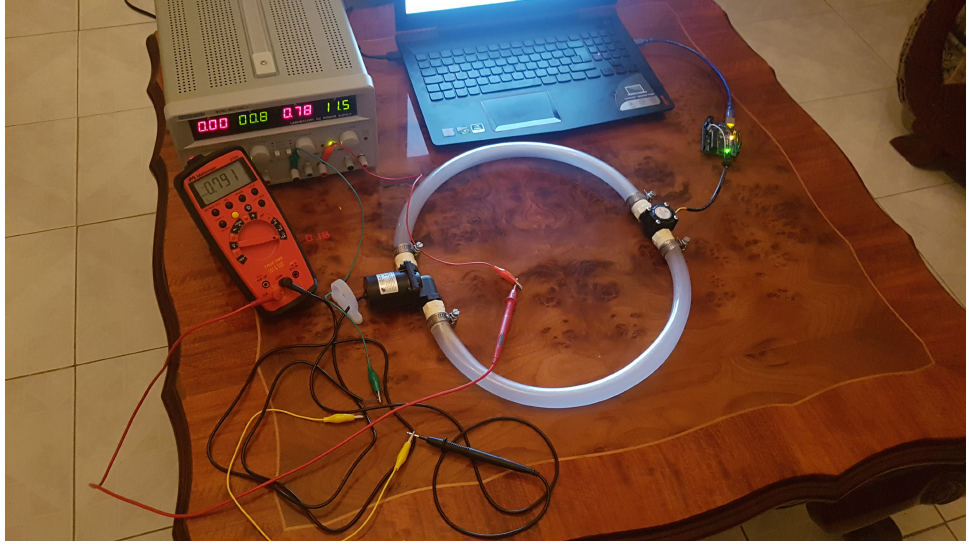
Figure 5. Experimental prototype. Table 2. Measurements of the volume flow rate and electric current while varying the